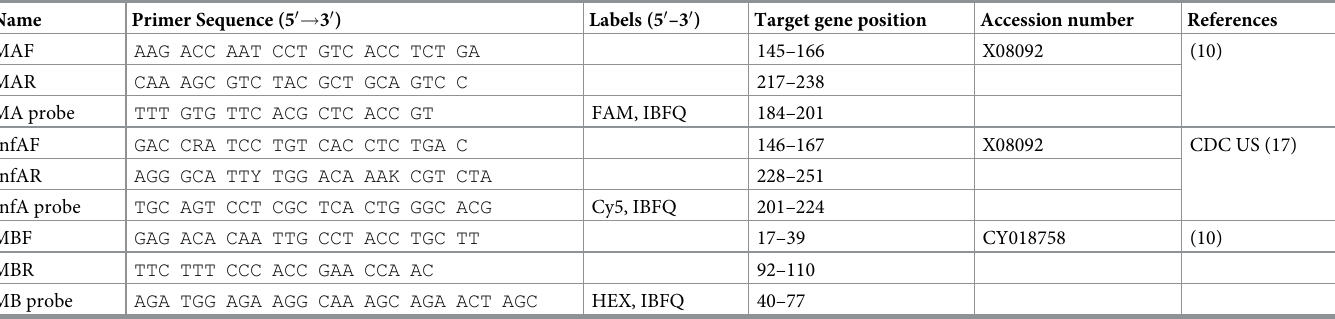
Table 1. Primer and probe sequences for the real-time RT-PCR for the detection of Influenza A and B